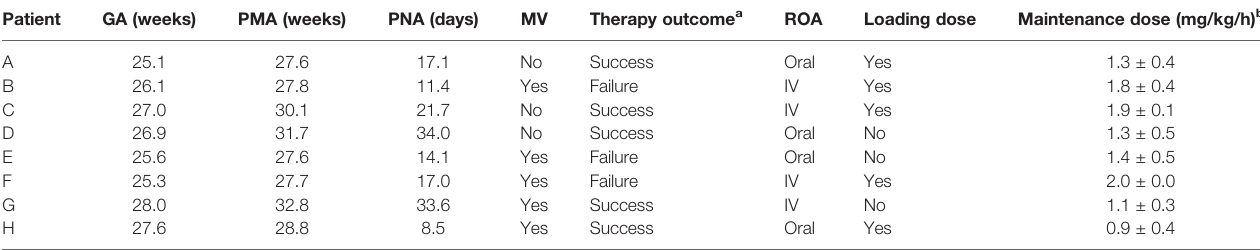
TABLE 1 | Baseline characteristics of the subset (n=8).